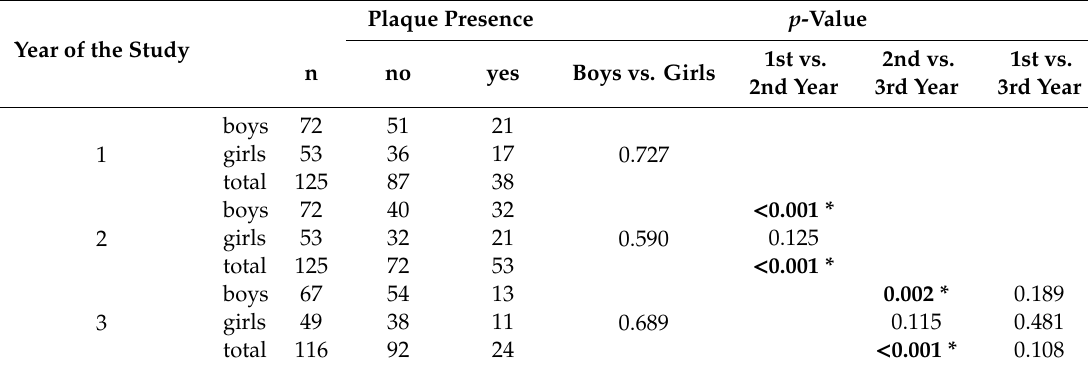
Table 3. The plaque presence and cariogenic